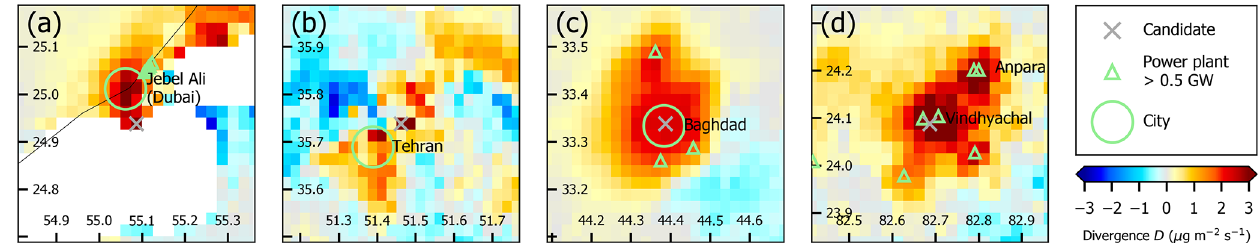
Figure 3. Clippings of the mean divergence (2019–2020) showing examples for the different categories of point source candidates checked during pre-classification. White indicates missing data. The location of power plants from GPPD as well as cities is indicated by green markers. (a) “Gap” candidate near Jebel Ali/Dubai. (b) “Negative” candidate near Tehran. (c) “Area source” around Baghdad. (d) “Area source” candidate covering several power plants (with Vindhyachal and Anpara being the largest) in India.